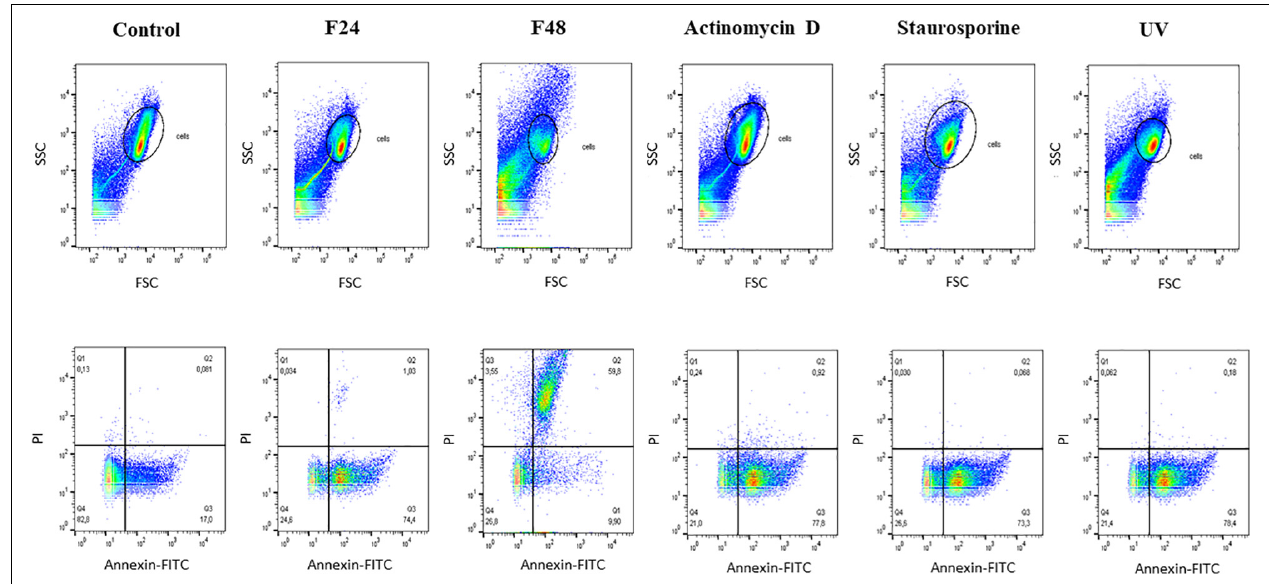
FIGURE 3 | Flow cytometry analysis of apoptosis and necrosis induced in G. mellonella hemocytes by C. coronatus infection. The analysis was performed using the Dead Cell Apoptosis Kit with Annexin V FITC and PI (Thermo Fisher Scientific). The results are shown as two dot plots comparing forward scatter (FSC) with side scatter (SSC) and PI with Annnexin-FITC. Fungal infection-induced changes were compared to controls, both negative and positive. Control (negative control), non-infected, healthy larvae; F24, larvae sampled immediately after 24-h exposure to C. coronatus sporulating colonies; F48, larvae sampled 24 h after 24-h exposure; Actinomycin D, staurosporine and UV- positive controls.